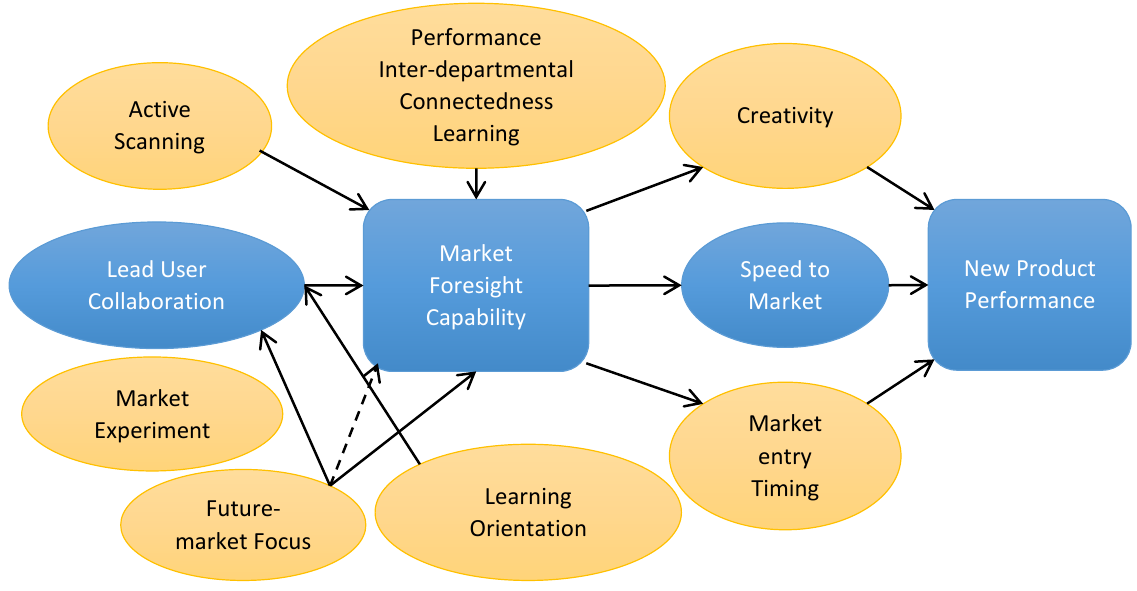
Figure 1. Determinants and outcomes of market foresight